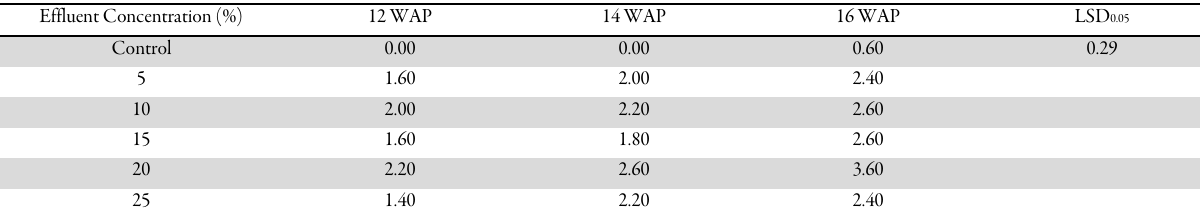
Table 4. Number of fruits of Solanum lycopersicum treated with different detergent effluent concentrations Effluent Concentration (%) 12